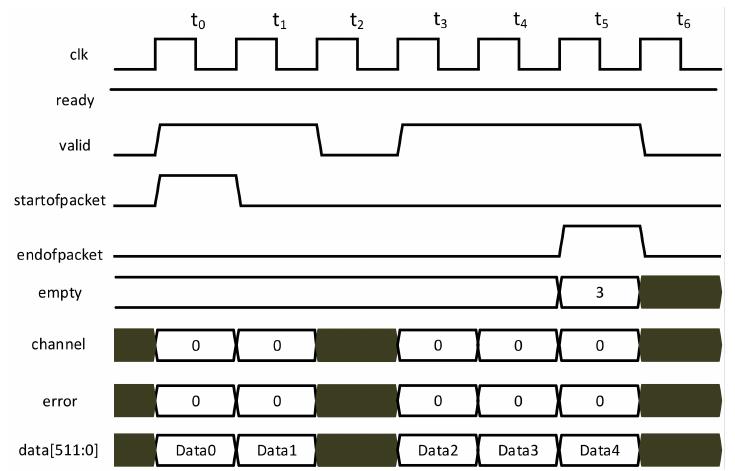
Figure 5. Timing waveform of Avalon interface working in packet transfer